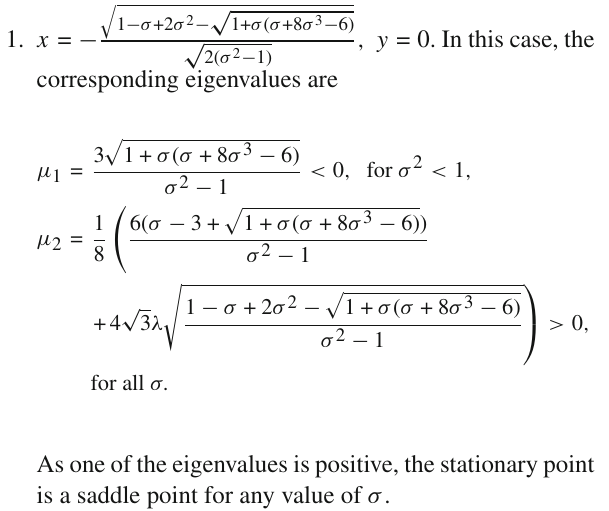
Fig. 3 The figure displays the phase space trajectories of Case (2) for Q = β ˙ ρ φ . It is plotted for β = − 2 and λ = 1. The point is stable and behaves as an attractive node